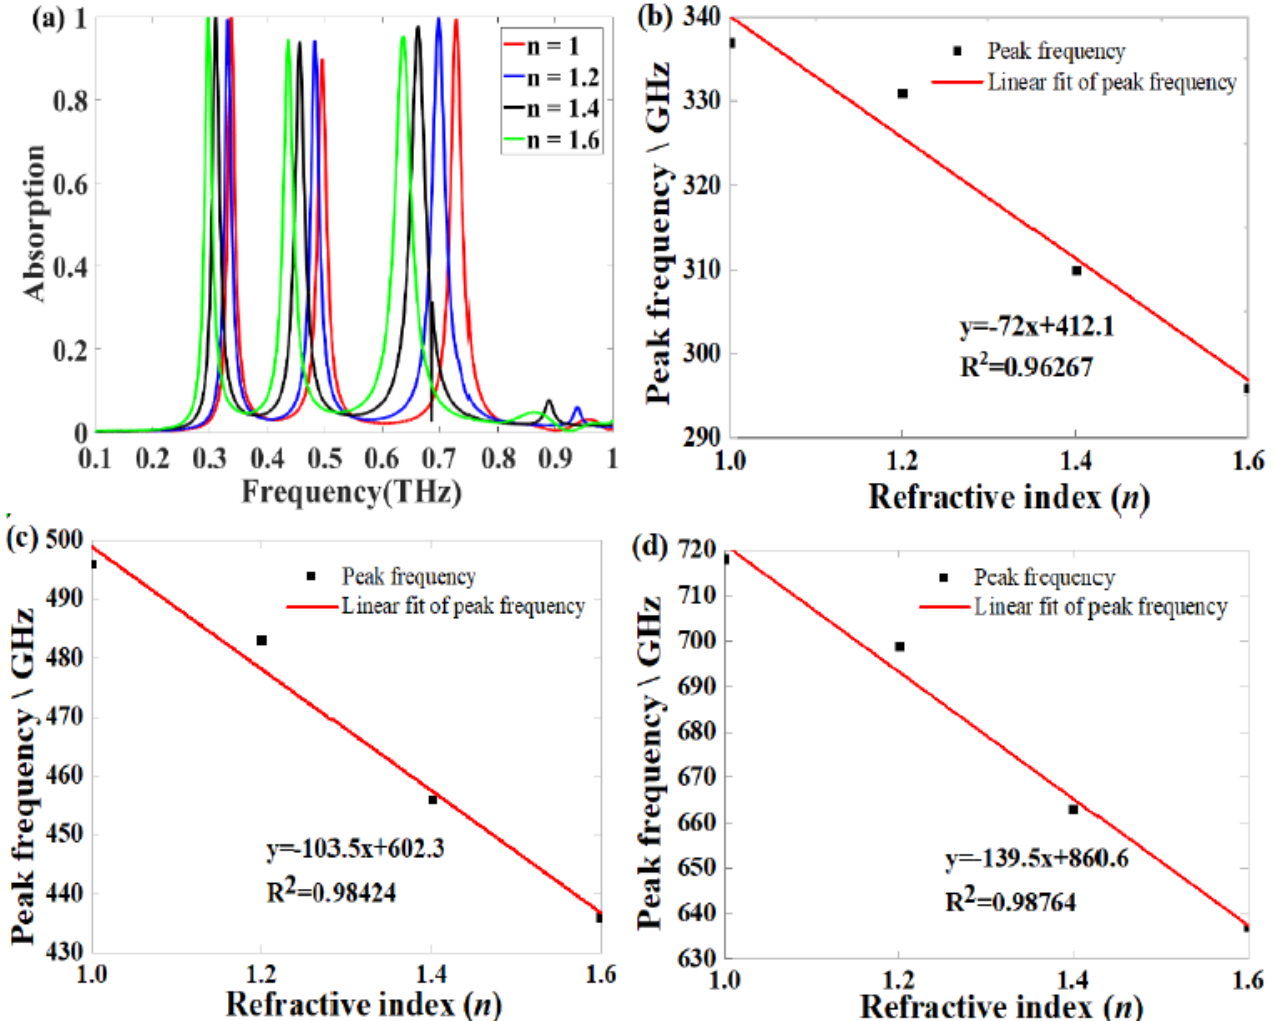
Figure 7. ( a ) Dependence of the absorption spectrum on the changes of the refractive index ( n ) of the surrounding; ( b – d ) corresponding linear fit of the three peaks’ frequency versus the corresponding n . Table 2. Sensitivity comparison results of various THz absorbers.